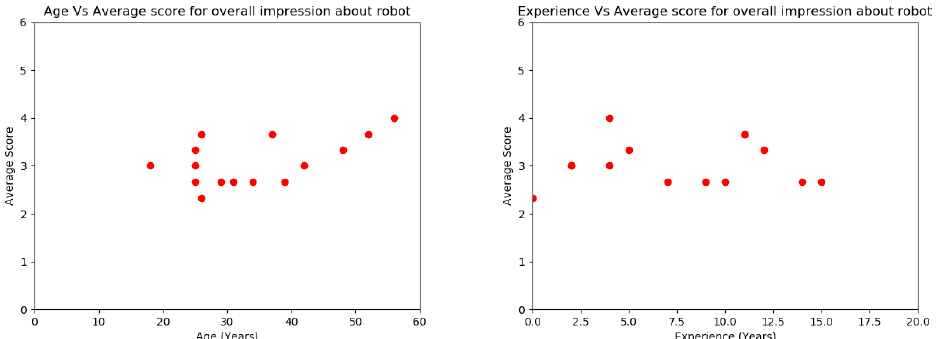
Figure 14. ( Left ) Relationship with age and the average score for overall impression. ( Right ) Rela- tionship with experience and the average score for overall